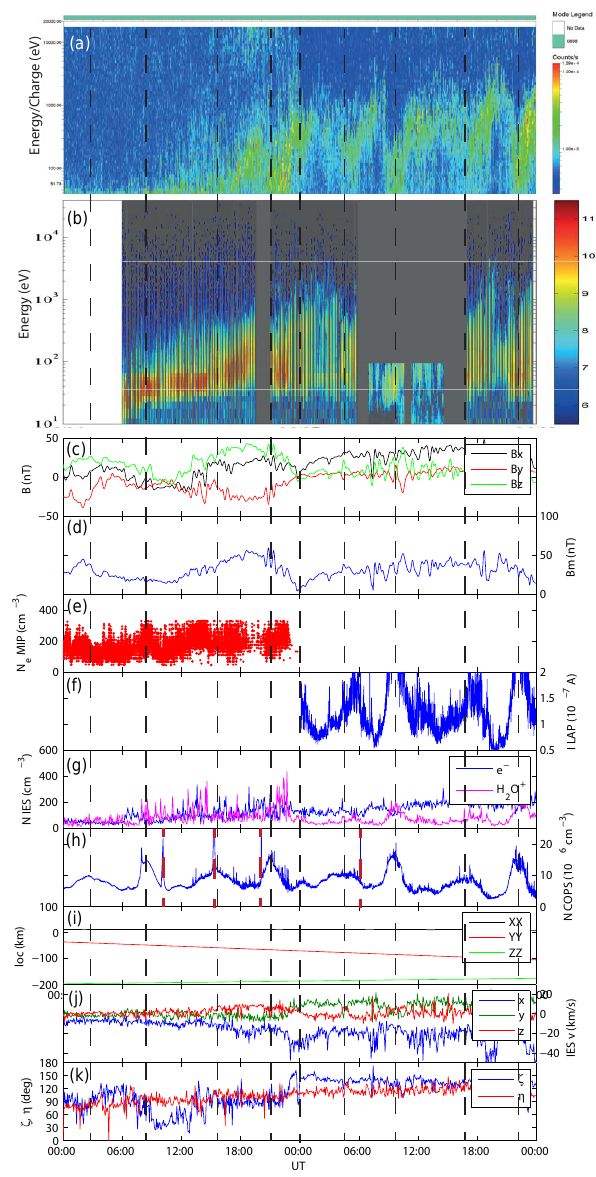
Figure 2. (a) The time-energy spectrogram of ion monitor of the IES instrument. (b) The time-energy spectrogram of the ICA in- strument. The low cut-off during the interval on 7 June between 07:00 and 15:00UT is caused by a mode change of the instrument. (c) The three components of the magnetic field in CSEQ coordi- nates. (d) The magnetic field strength. (e) The MIP-deduced elec- tron density. (f) The LAP P1 current. (g) The deduced electron and ion density from the IES instrument. (h) The neutral density from ROSINA COPS. (i) The location of Rosetta in CSEQ coor- dinates. (j) The ion velocity components from the IES instrument. (k) The angle η between the velocity vector and the radial direction to the comet and the angle ζ between the ion velocity vector and the magnetic field vector. The vertical lines are at 02:45, 08:30, 15:30, 21:00, 00:30, 04:15, 09:30, 16:45, and